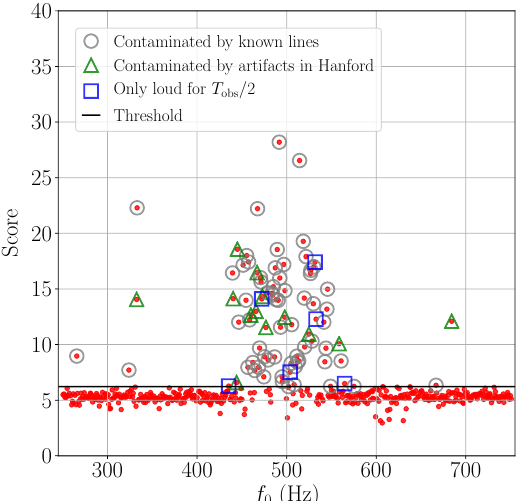
Figure 8. An example of how continuous wave candidates (red dots) are validated based on lists of known lines in the strain data and a variety of signal consistency checks. The threshold for additional followup is shown with a black line. Candidates that are vetoed due to overlapping the known frequency of an instrumental line are marked with gray circles. Candidates that are vetoed because the amplitude of the signal is higher in one detector than expected for an astrophysical signal are marked with green triangles. Candidates that are only significant when considering half of the total analysis time are marked with blue squares. Reprinted figure with permission from [118]; Copyright 2018 by the American Physical